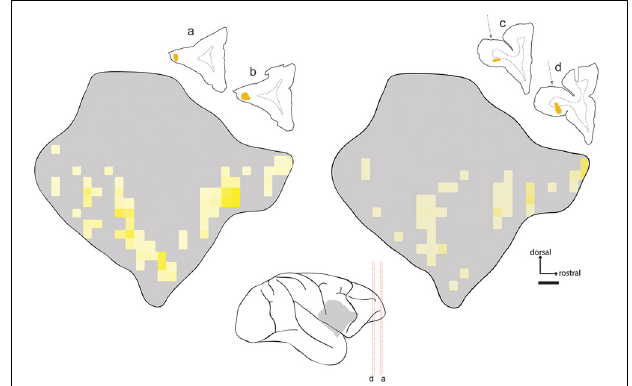
FIGURE 5 | Distribution of labeled neurons in claustrum following injections in area 12. Heat map projections for two injections of diamidino yellow (DY) in area 12 (cases FR02- left; FR04- right). Line drawings show injection locations in frontal sections. Center schematic image shows location of claustrum relative to tissue sections and major sulci of the Cebus brain (gray silhouette). Red dashed lines correspond to tissue sections as marked. The dotted arrows on the right indicate the approach used for injection of area 12o, which traversed the cortical white matter overlying that area. Implications of this approach for interpretation of the data are described in the